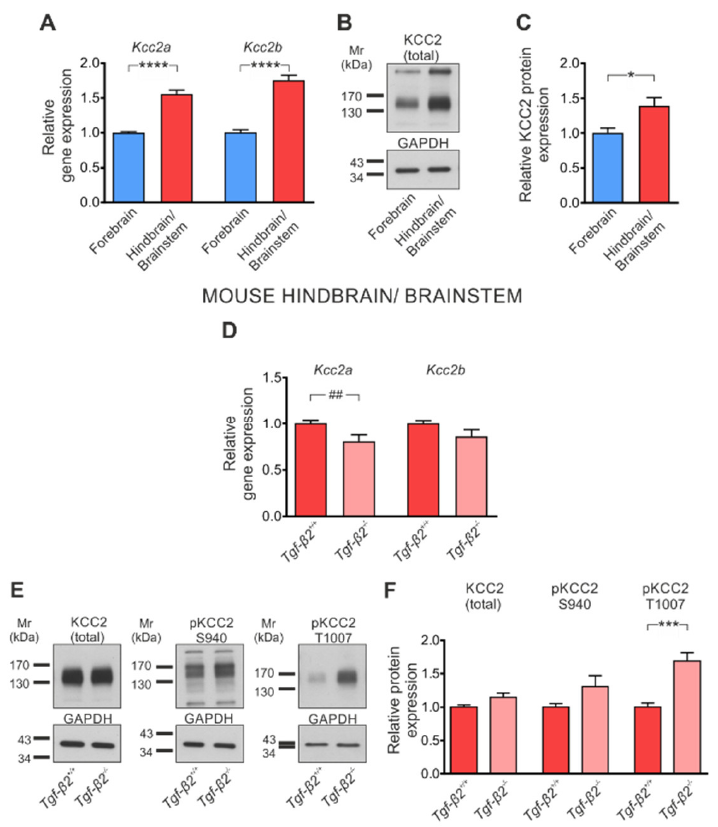
Figure 5. TGF- β 2-dependent regulation of KCC2 in the mouse hindbrain/brainstem. ( A ) Quantitative RT-PCR analysis for Kcc2a and Kcc2b on cDNA from either mouse forebrain or hindbrain/brainstem at embryonic (E) day 17.5 (**** p < 0.0001 for significant upregulation compared to forebrain using two-tailed unpaired Student’s t -test with Welch’s correction, n = 10). ( B ) Immunoblot analysis for total KCC2 in tissue homogenates from mouse forebrain and hindbrain/brainstem at E17.5. ( C ) * p < 0.05 for significant increase after densitometric analysis of the signal ratio KCC2: GAPDH and Student’s t -test, n = 6. Data are shown as mean ± S.E.M. relative to the mean of forebrains. The blots are representative of six different litters. A total of 30 µ g protein was loaded per lane. ( D ) Quantitative RT-PCR analysis for Kcc2a and Kcc2b on cDNA from hindbrain/brainstem at embryonic day (E) 17.5 of Tgf- β 2 +/+ and Tgf- β 2 − / − mice ( ## p < 0.01 using Mann–Whitney test, n = 7 for wildtype and n = 6 for mutant). ( E ) Immunoblot analysis for total KCC2 and for phosphorylated (p)KCC2 at S940 or T1007 in tissue homogenates from hindbrain/brainstem of Tgf- β 2 +/+ and Tgf- β 2 − / − mice. ( F ) *** p < 0.001 for significant increase after densitometric analysis of the signal ratio pT1007: GAPDH and two-tailed unpaired Student’s t -test, n = 6 for wildtype and n = 6 for mutant. The blots are representative for four different litters. A total of 30 µ g protein was loaded per lane. Data are shown as mean ± S.E.M. relative to the mean of wildtype littermates.